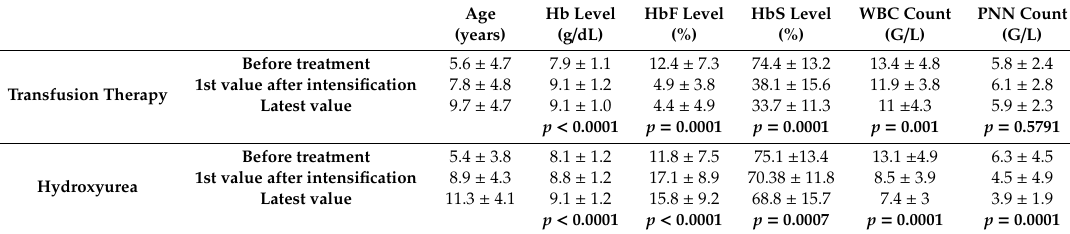
Data are mean ± SD. Bold values indicate significance at p <